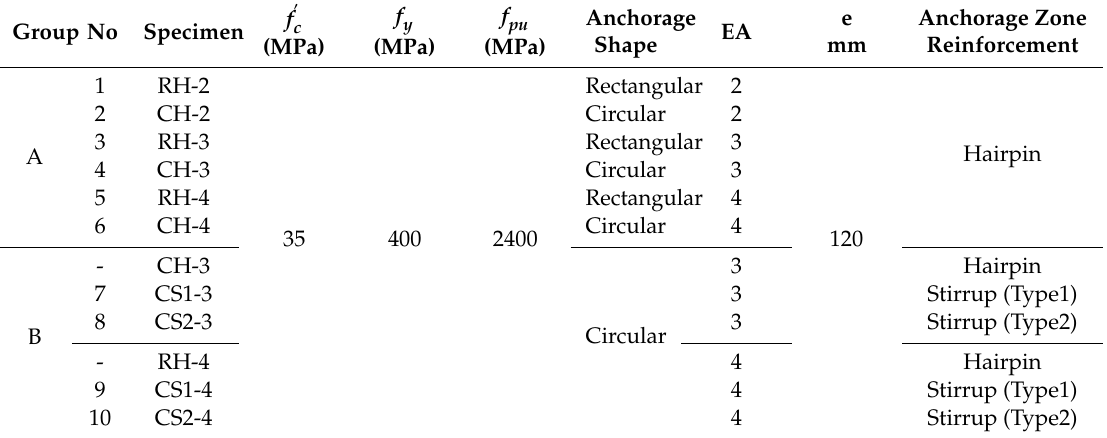
Table 1. Details of experimental specimens.